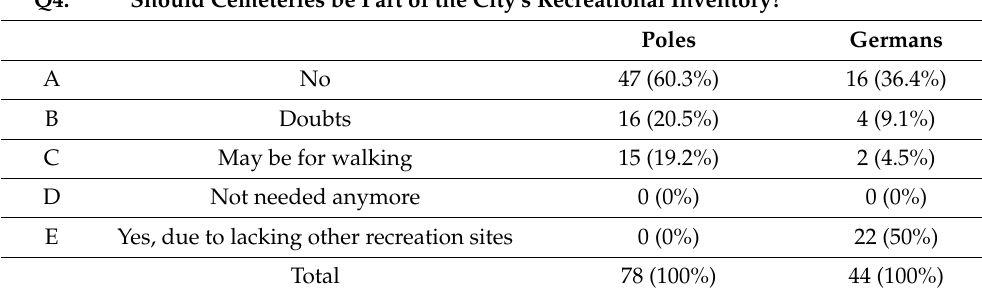
Table 5. Respondents’ opinion on the studied cemeteries as part of the city’s recreational